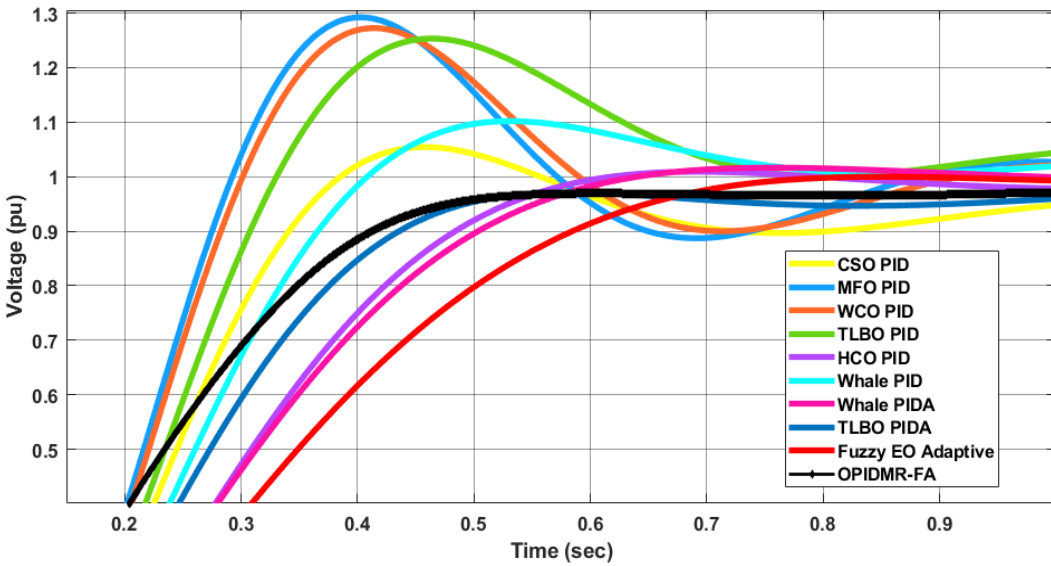
Figure 8. Magnified view of Figure 7.